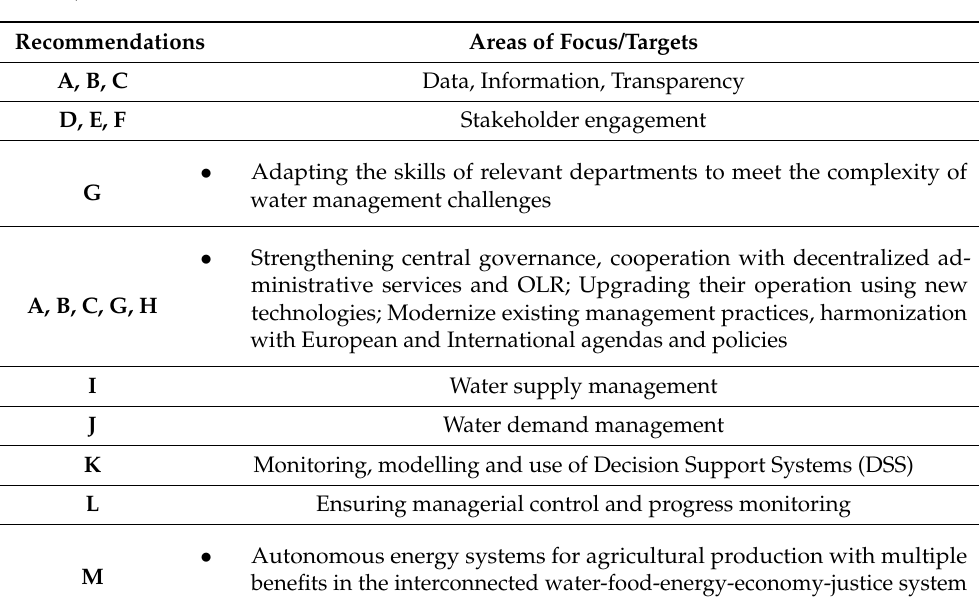
Table 3. Areas of focus/targets (right column) and the respective policy recommendations (left